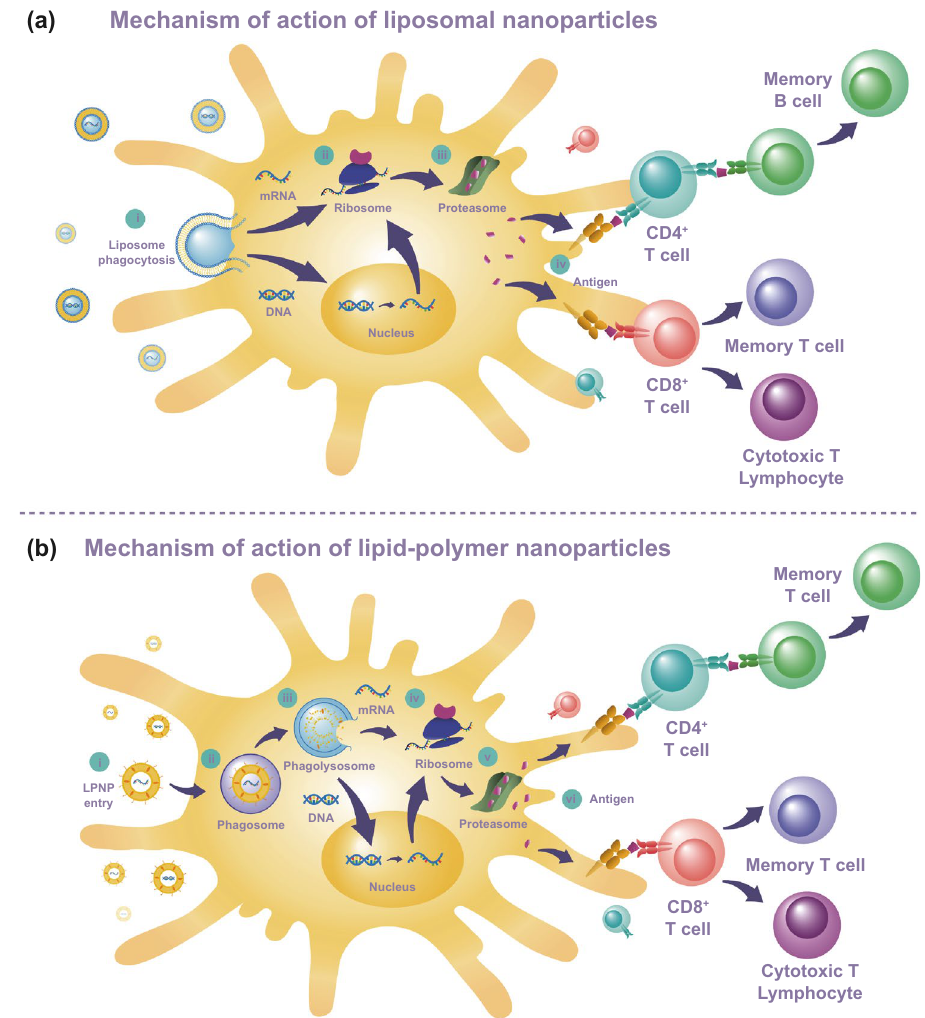
Fig. 4 Schematic representation of nucleic acid‑based nanovaccination mechanism. a Liposomal nanoparticle vaccines (i) The liposomal nano‑ particle reaches APC membrane and fuses. (ii) If the cargo is mRNA, it reaches the cytoplasm and is ready for translation. If the cargo is DNA, it must reach the nucleus for transcription into an mRNA molecule. (iii) Subsequently, ribosomes will translate the mRNA molecules into pro‑ teins. (iv) Proteasome activity will break the protein down in small antigenic fragments. (v) The antigenic fragments are presented on the APC membrane, and stimulation of the innate immune response is initiated by CD4 + and CD8 + T cells. b Lipid‑polymer nanoparticle vaccines (i) lipid polymer nanoparticle (LPNP) reaches APC membrane. (ii) The LPNP is taken up by a phagosome or endosome. (iii) As the phagosome or endosome ages, a phago‑ or endo‑lysosome is formed and later disrupted due to pH changes releasing the genetic material to the cytoplasm. If the cargo is mRNA, it reaches the cytoplasm and is ready for translation. If the cargo is DNA, it must reach the nucleus for transcription into an mRNA molecule. (iv) The ribosomal machinery begins translating the mRNA to produce a protein. (v) Proteasome activity causes the break‑ down of the protein in small antigenic fragments. (vi) The antigenic fragments are presented on the APC membrane for stimulation of the innate immune system by CD4 + and CD8 + T